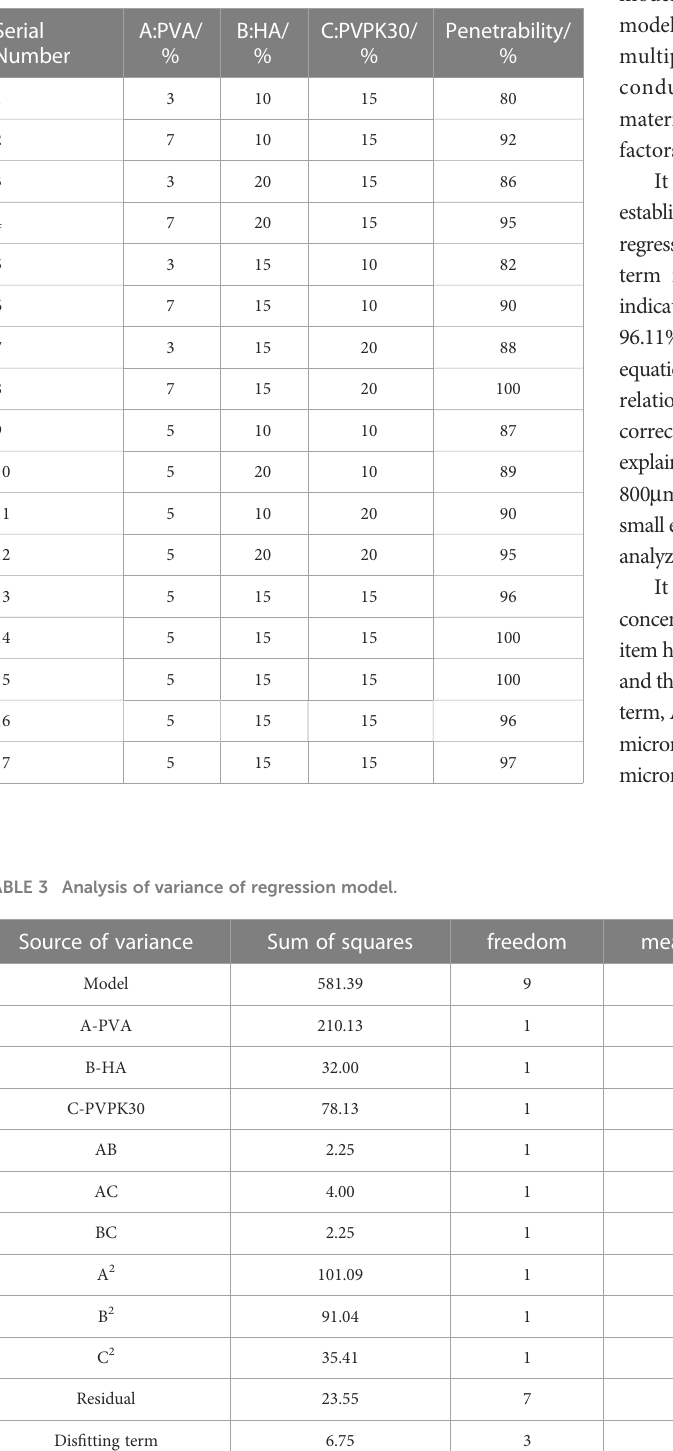
TABLE 2 Response surface tests and results of drug-loading